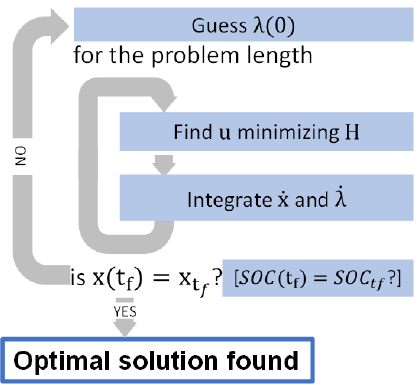
Figure 8. PMP solution